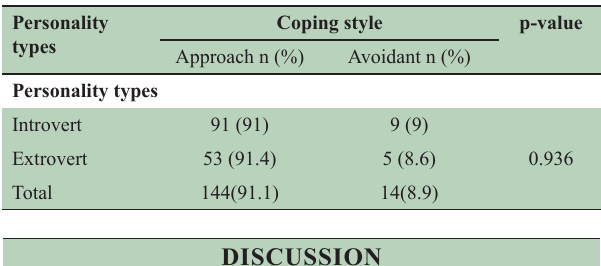
Table-II: Association between personality types and coping